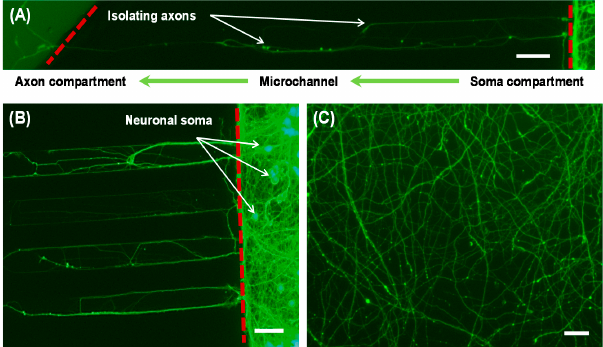
Figure 5. ( A , B ) Axons being isolated from the neuronal somata by the shallow microchannels connecting the soma compartment and the axon compartment. Red dotted lines indicate compartment boundaries. ( C ) Isolated axonal layer inside the soma compartment at DIV 12. Cells were stained with Calcein-AM for visualization. Scale bars: 50 μ m. In order to carry out six sets of independent localized biomolecular treatments with four replicates for each condition, fluidic isolation between the soma compartment and the axon compartments as well as fluidic isolation among 24 axon compartments is required. Fluidic isolation between the soma compartment and the axon compartments was achieved by generating fluidic level difference between the compartments that counters diffusion of locally treated biomolecules (Figure 6A,B). For the developed platform, culture medium is changed all together by a single aspiration at the exchange port via culture medium outflow channel. Although all axon compartments are connected via medium outflow channel, during replenishment, culture medium from one axon compartment cannot flow into any other axon compartments as demonstrated by the fluidic simulation results. In addition, culture medium inside the axon reservoirs and medium outflow channel is all aspirated out after the replenishment procedure (Figure 6B), thereby ruling out any potential risk of cross contamination among axon compartments. In order to demonstrate the fluidic isolation and the multiple localized biomolecular treatment capability, only the isolated axons connected to two reservoirs (blue and orange reservoirs in Figure 7A) were exposed to CSPG (5 μ g/mL), a family of proteoglycan known to negatively regulate axon growth and cause retraction/degeneration of the established CNS axons. After 48 h, Calcein-AM staining of the axons inside the axon compartment revealed significant degeneration and fragmentation of the isolated axons inside the axon compartments treated with CSPG compared to the control (Figure 7B,C). This clearly demonstrates that the developed platform can indeed be used as a high-throughput compartmentalized neuron culture platform for screening potential drugs that promote axon growths.